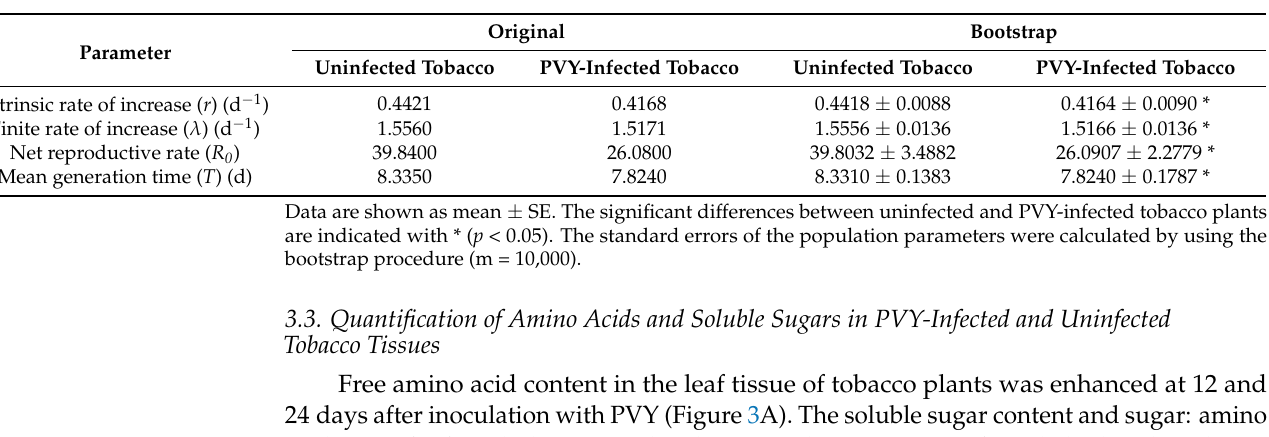
Figure 2. ( A ) Age-specific survival rate ( lx ), ( B ) age-specific fecundity of the total population ( m x ), and ( C ) age-specific maternity ( l x m x ) of M. persicae on uninfected and PVY-infected tobacco plants. Table 3. Population parameters of M. persicae on uninfected tobacco and PVY-infected